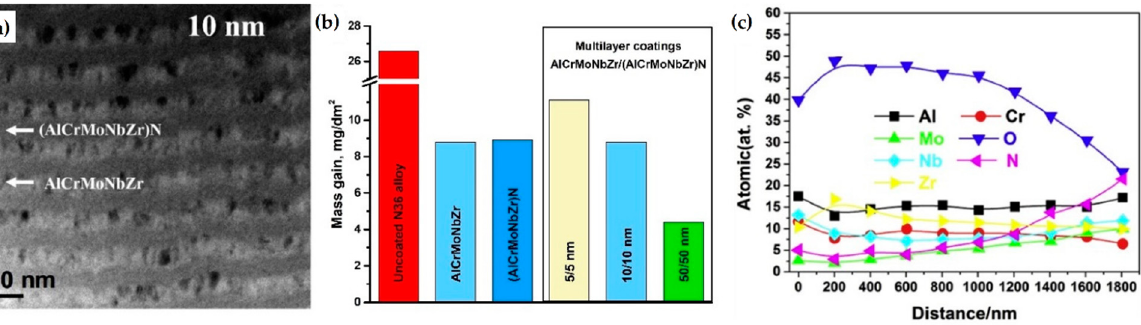
Figure 17. AlMoCrNbZr/(AlMoCrNbZr)N HECe coatings: ( a ) TEM image of the cross-section of 10/10 nm coatings, ( b ) HECe-coated N36 Zr alloy mass gains during autoclave test at 360 °C, 18.7 MPa for 30 days. ( c ) Depth of elemental distribution of 50/50 nm HECe coatings after autoclave test [170]. Reprinted with permission from [171] Copyright 2018 Elsevier.